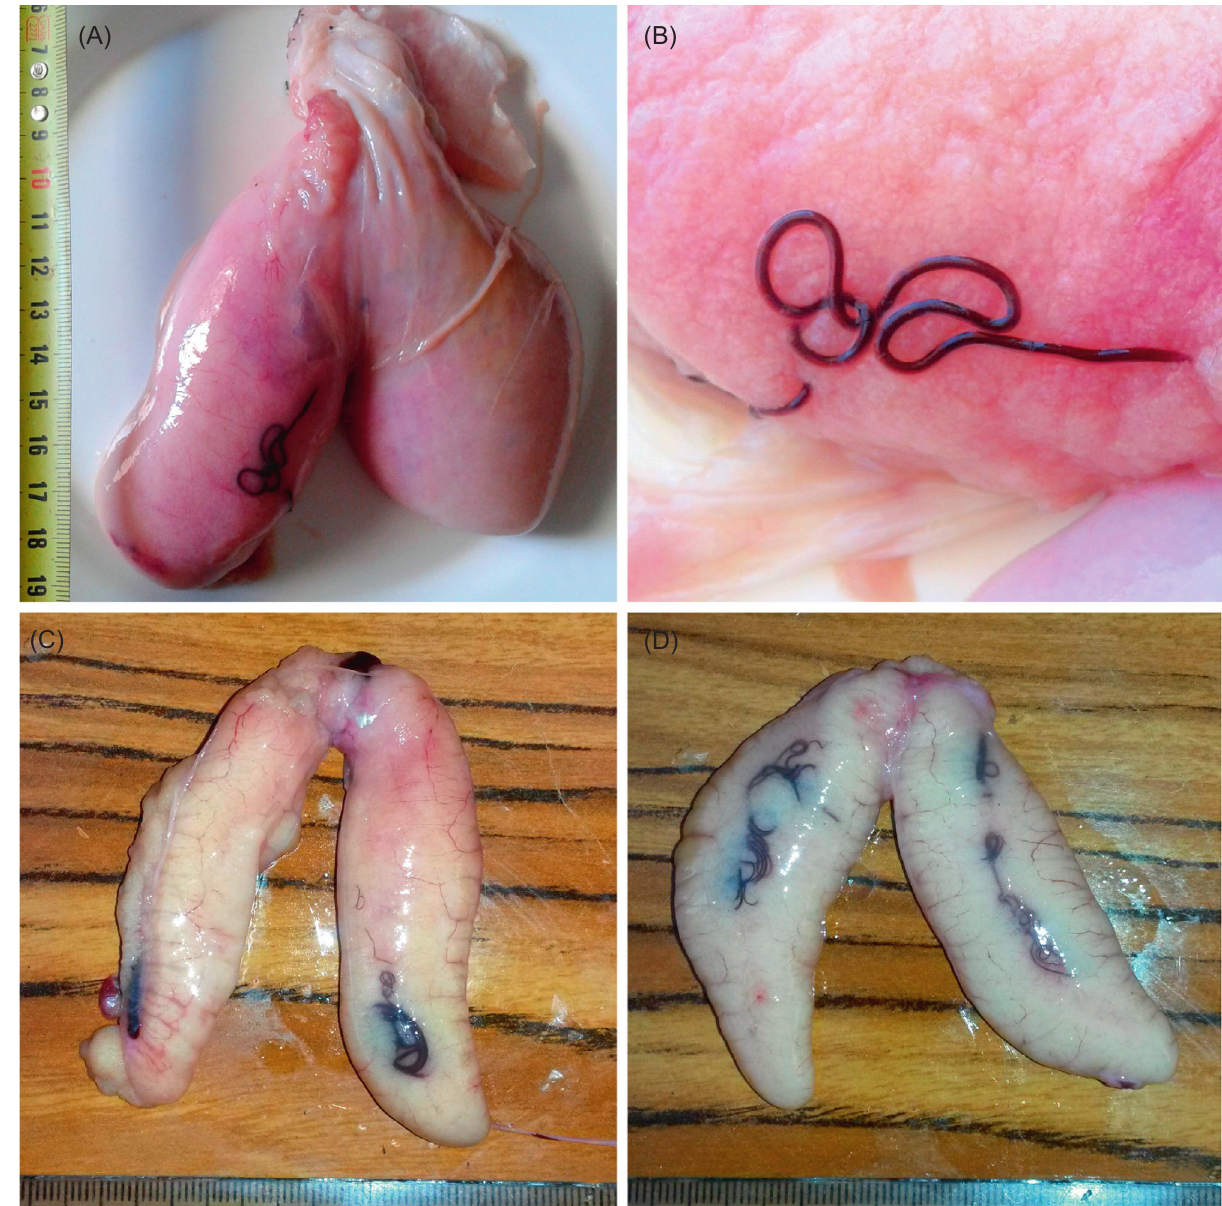
Figure 1. Ovaries of fish with visible Philometra females. (A, B) Hyporthodus haifensis with Philometra rara n. sp. (A) intact ovaries; (B) ovary with tunica removed. (C, D) Pomatomus saltatrix with Philometra saltatrix , two specimens. Scales: